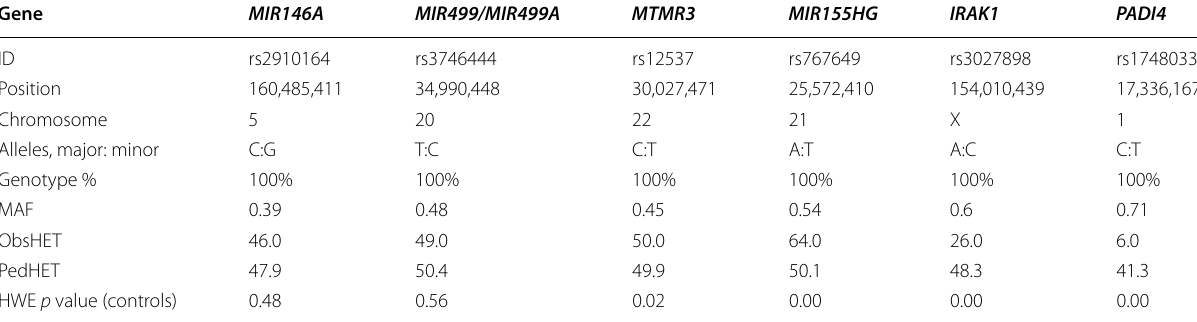
MAF minor allele frequency, ObsHET observed heterozygote, PedHET predicted heterozygote, HWE Hardy–Weinberg equilibrium